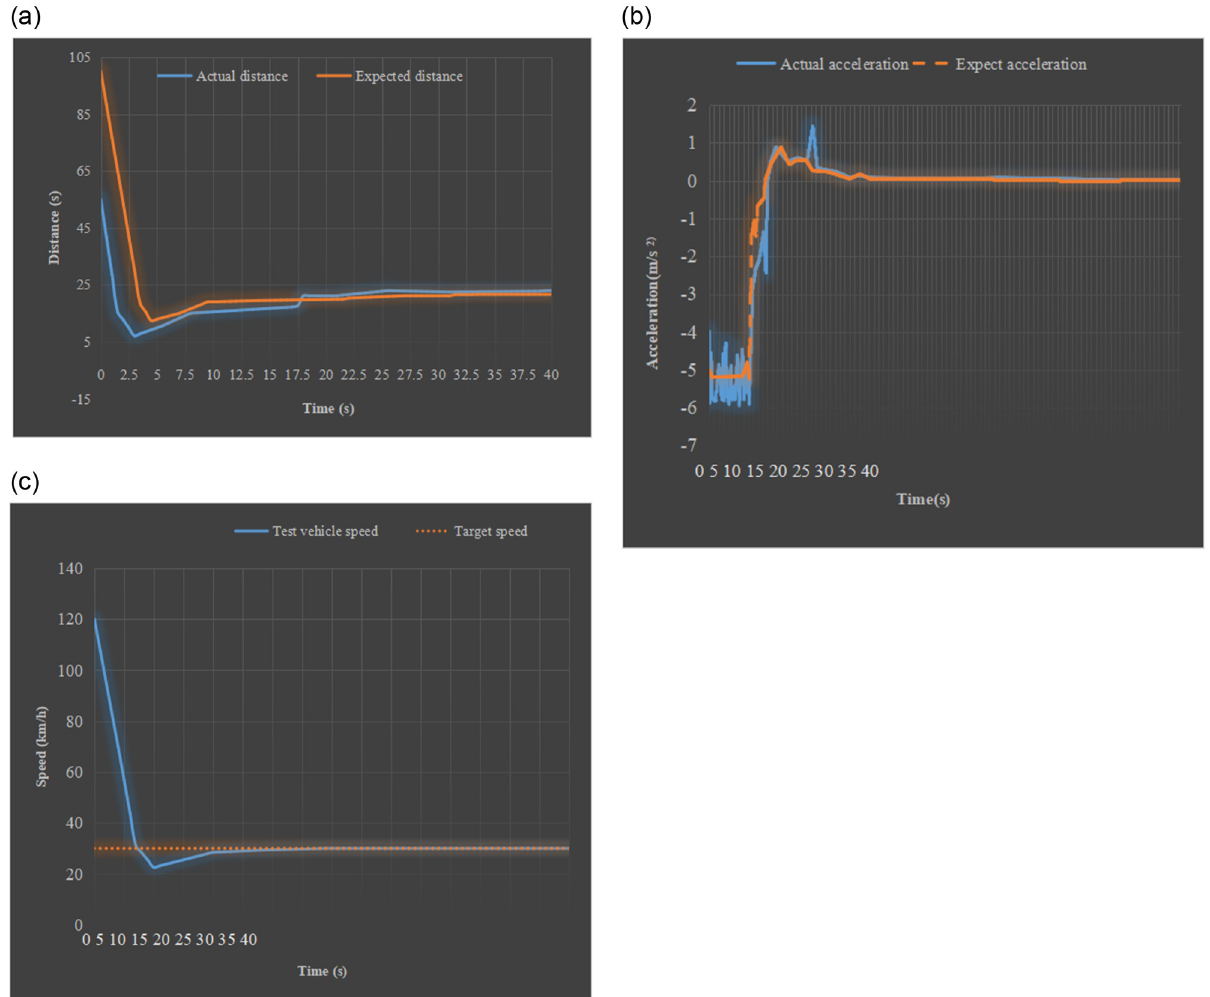
Fig 14. Anti-collision simulation results of the target vehicle driving at a constant speed (a) comparison between expected distance and actual distance (b) comparison between expected acceleration and actual acceleration (c) speed comparison between the two vehicles.